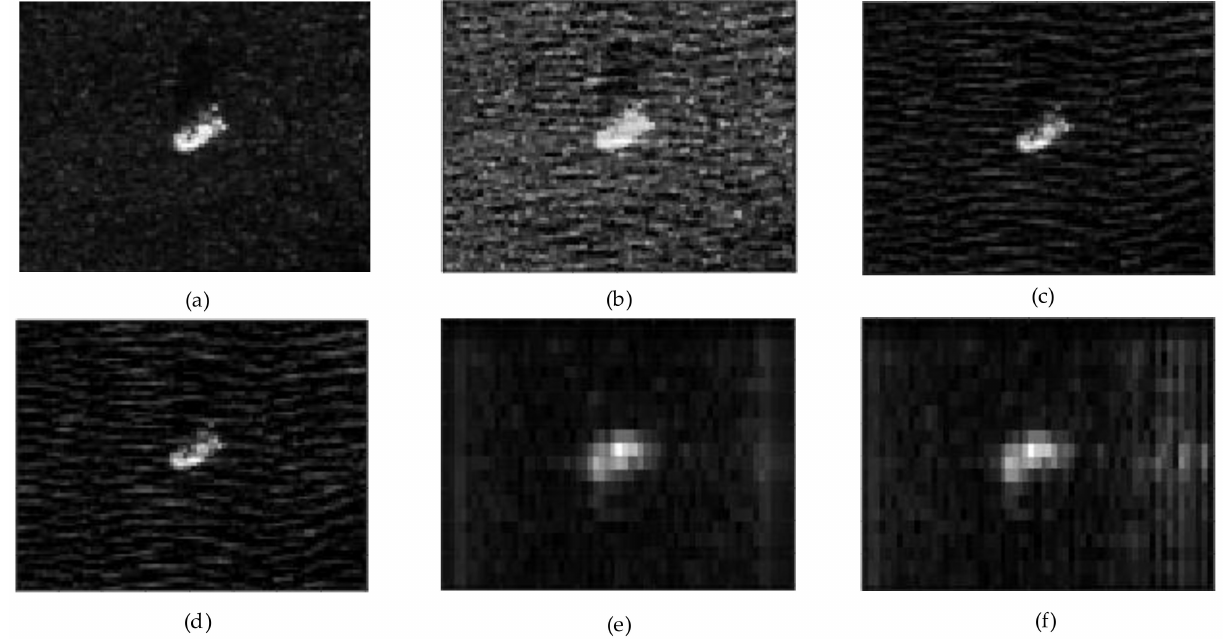
Figure 5. ZSU-23–4 imaging results. ( a ) is original vehicle target, ( b ) is our proposed method with L = 3, ( c ) is our proposed method with L = 8, ( d ) is our proposed method with L = 11, ( e ) is ISTA method and ( f ) is Fast ISTA